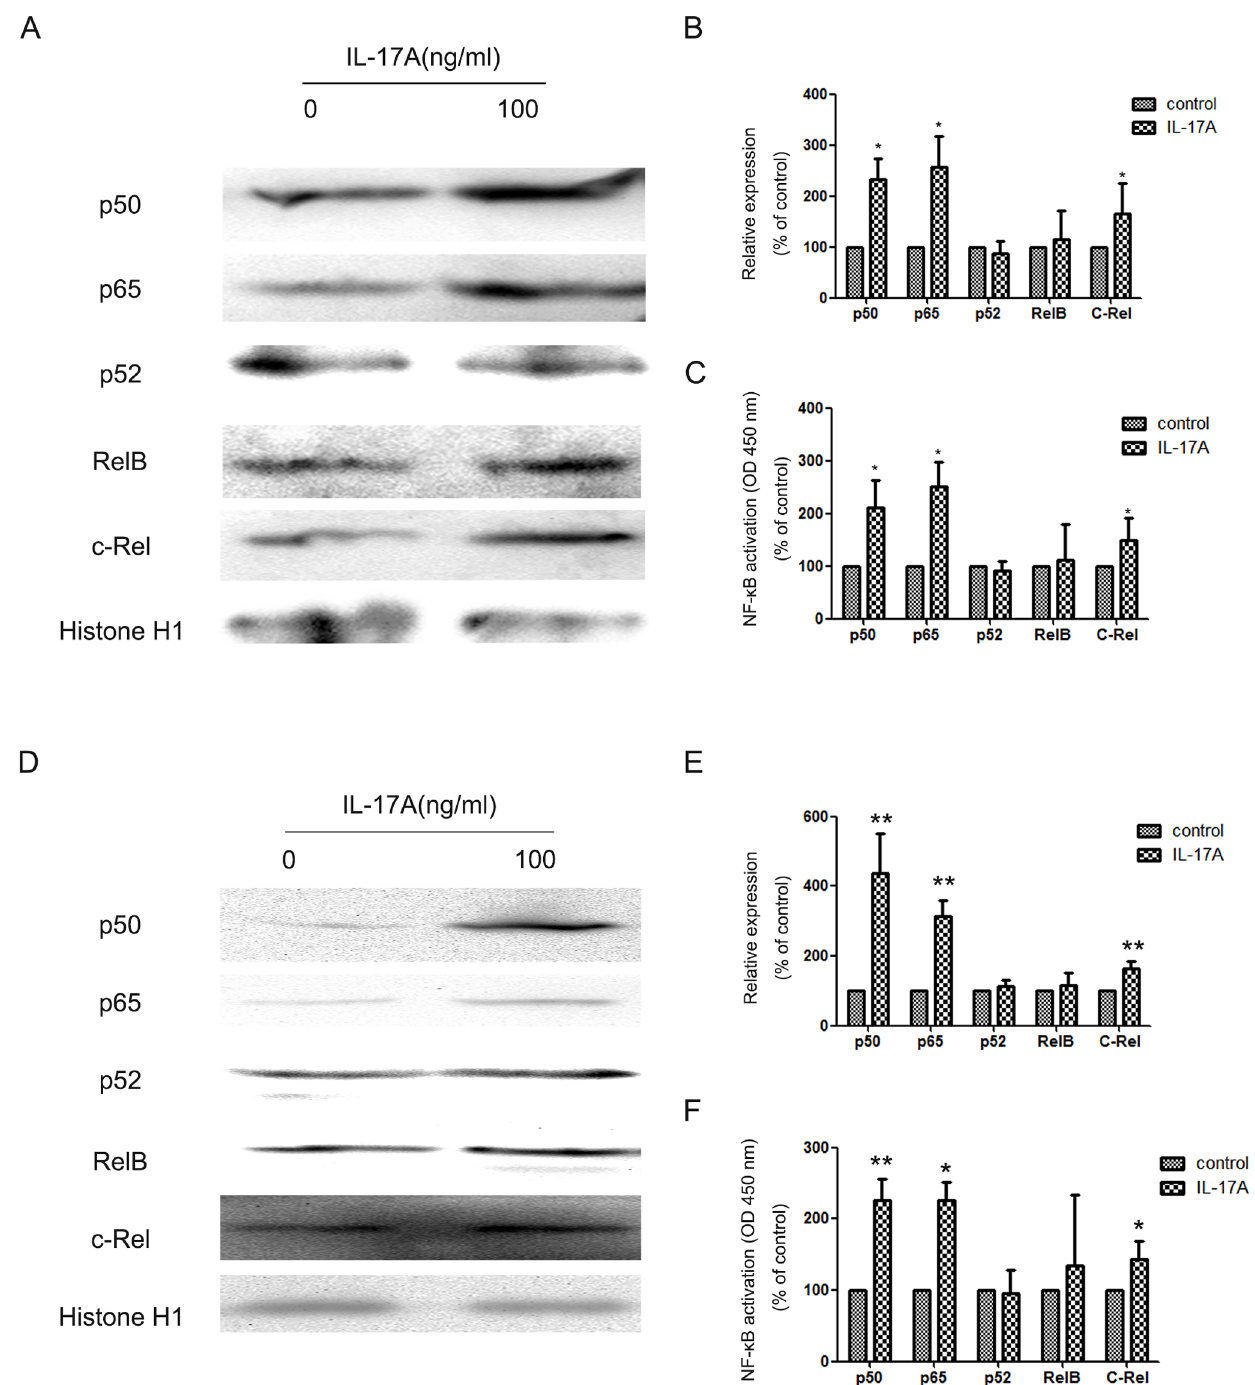
Figure 5. IL-17A activated NF- k B NPC in NPC cells. (A) Western blotting analysis was used to detect nuclear p52, p50, p65, c-Rel and RelB expression in NPC-039 cells treated with IL-17A. (B) Quantification of the protein levels of nuclear p52, p50, p65, c-Rel and RelB in NPC-039 cells. (C) The DNA-binding capacity of NF- k B in NPC-039 cells was measured using TransAM NF- k B ELISA. (D) Western blotting analysis was used to detect nuclear p52, p50, p65, c-Rel and RelB expression in CNE-2Z cells treated with IL-17A. (E) Quantification of the protein levels of nuclear p52, p50, p65, c- Rel and RelB in CNE-2Z cells. (F) The DNA-binding capacity of NF- k B in CNE-2Z cells was measured using TransAM NF- k B ELISA. Values represent the means 6 SD of three independent experiments performed in triplicate. * p , 0.05 compared with the control group.